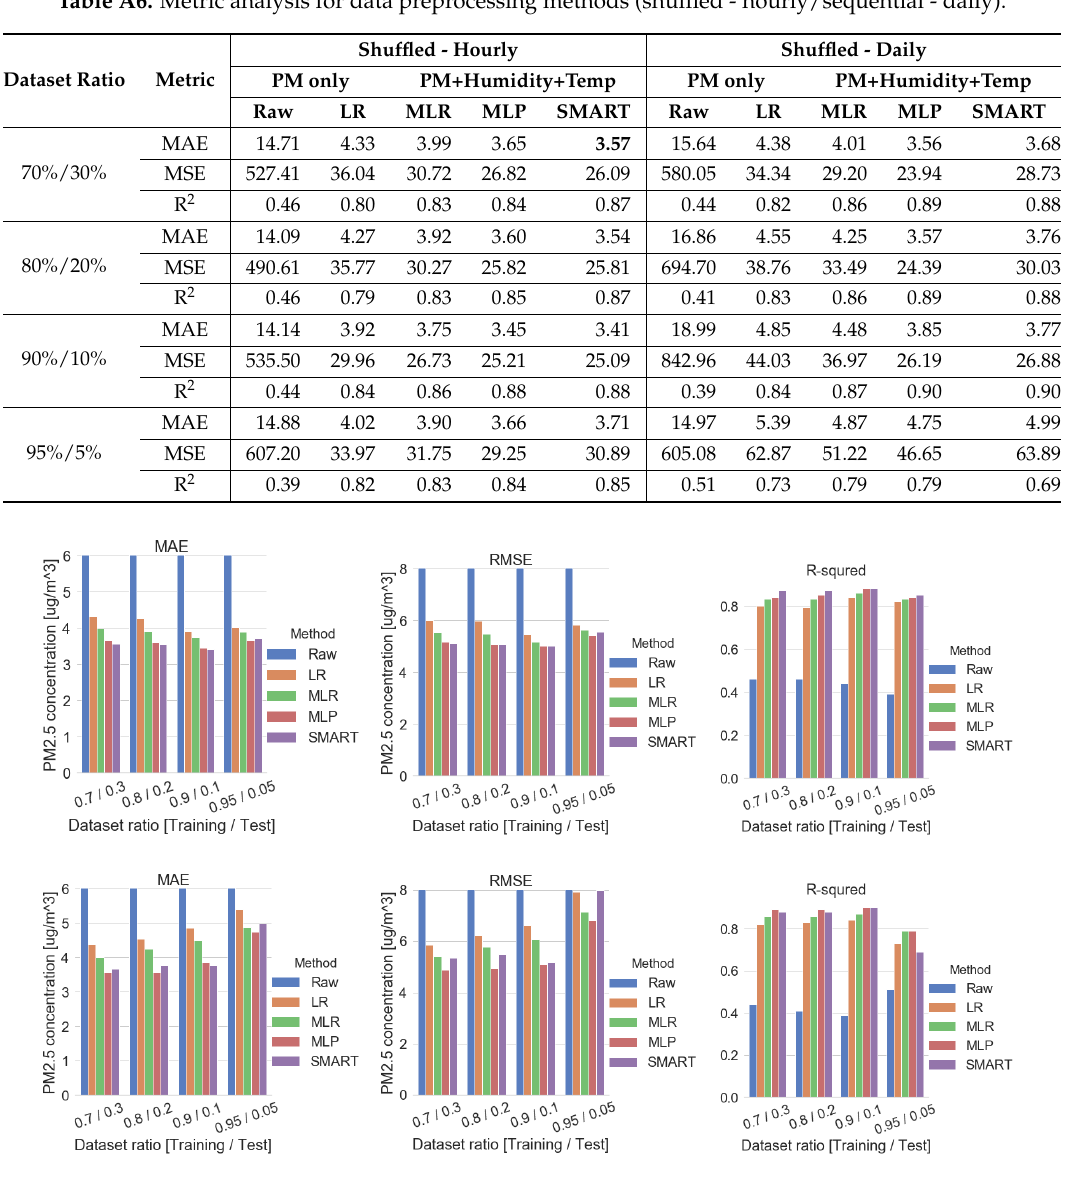
Figure A6. Comparison plot by data preprocessing methods: shuffled - hourly ( top )/shuffled - daily ( bottom